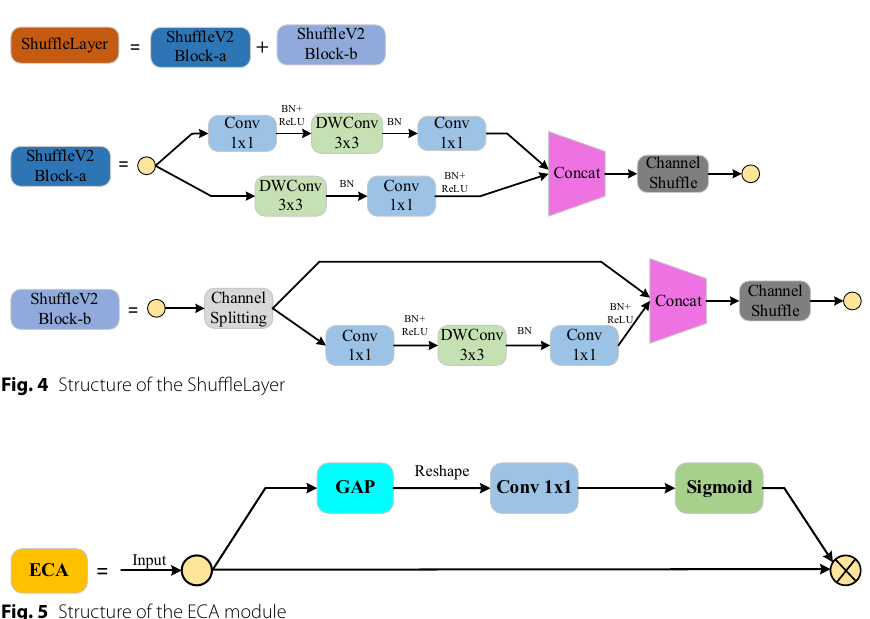
Fig. 5 Structure of the ECA